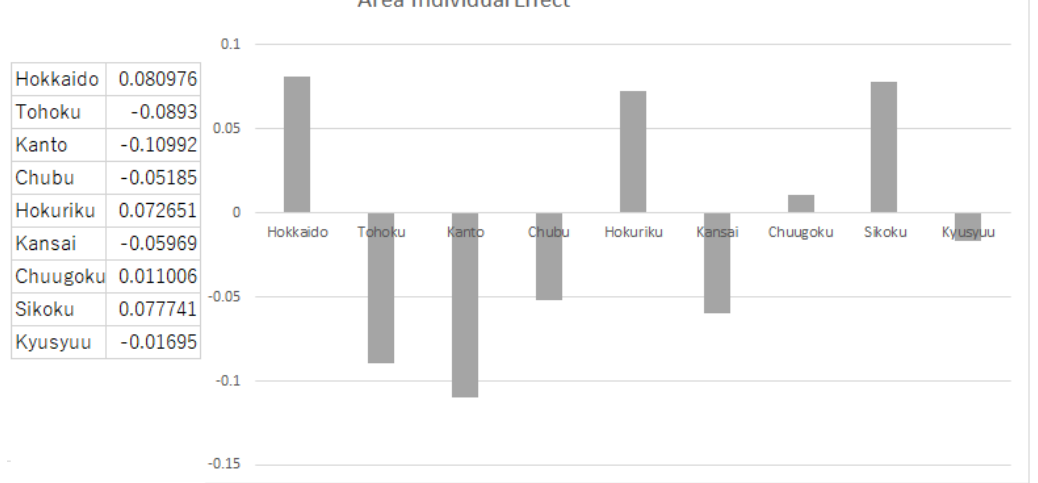
Figure 6. Individual Effect of 9